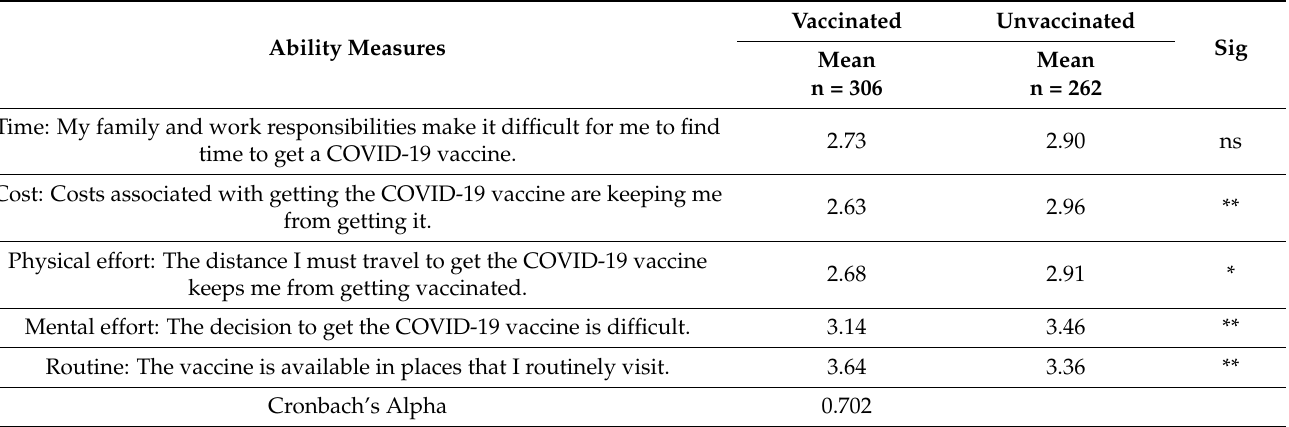
Table 4. COVID-19 vaccination status by ability measures.